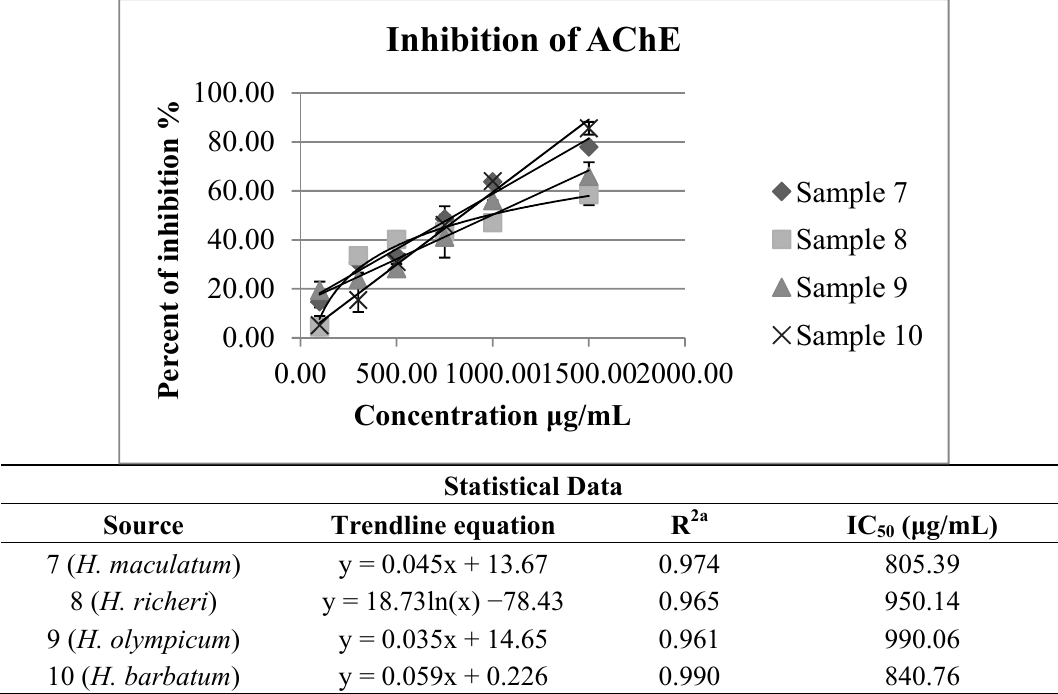
Figure 4. Inhibition of acetylcholinesterase by investigated H. maculatum